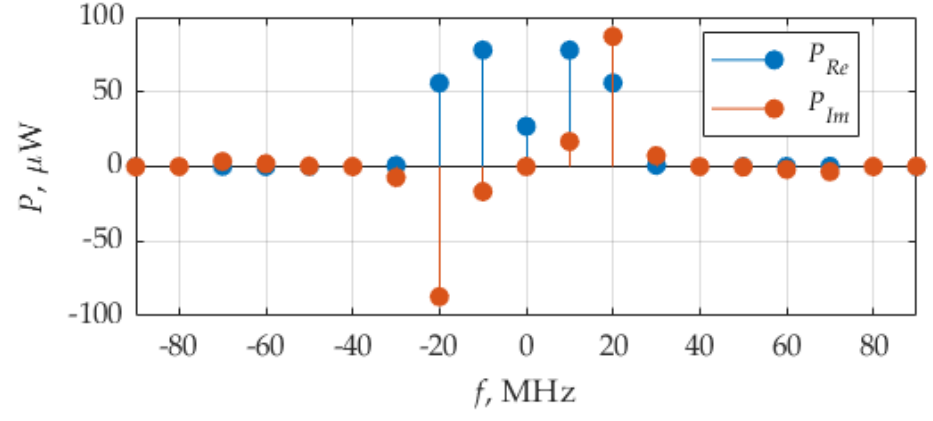
Figure 18. Average power distribution for the case of transmission line and pulse train current.